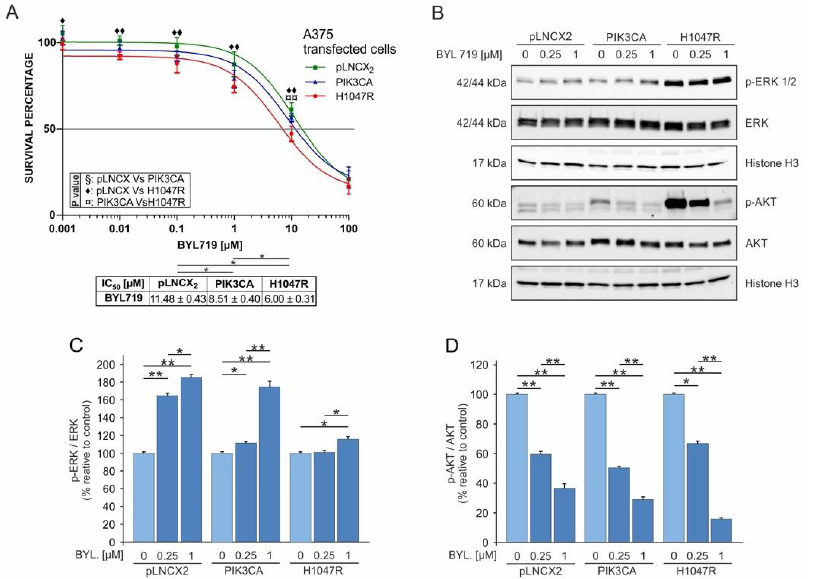
Figure 5. Treatment of A375 pLNCX2 , A375 PIK3CA , and A375 H1047R cells with BYL719. ( A ) Cell viability evaluated by MTT assay after 72 h of treatment with BYL719 (0.001–0.01–0.1–1–10–100 μM). ( B – D ) Western blot analysis of p-ERK, p-Akt, total ERK, and total Akt protein levels in A375 cells treated for 48 h with BYL719 (0.0–0.25–1 μM). All experiments were performed in triplicate. * p ≤ 0.05; ** p ≤ 0.01; ◆ = p ≤ 0.05; ◆◆ , ¤¤ = p ≤ 0.01.